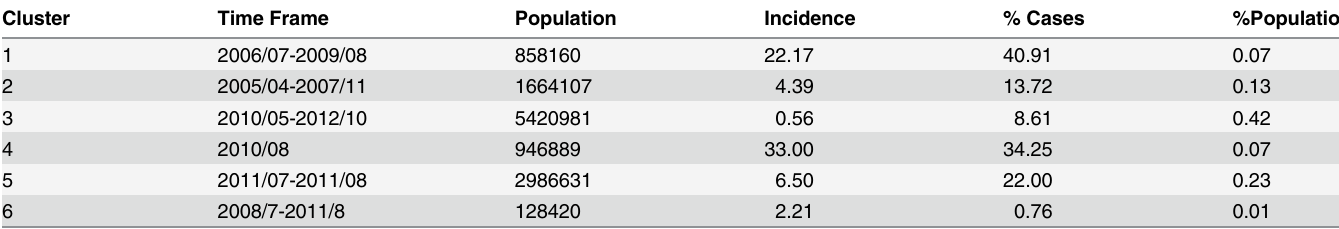
Incidence: cases per 100000 person year; %Population: the percentage of population living in cluster/the total population; %Cases: the percentage of cutaneous anthrax cases observed in cluster/the total cases during the same time.